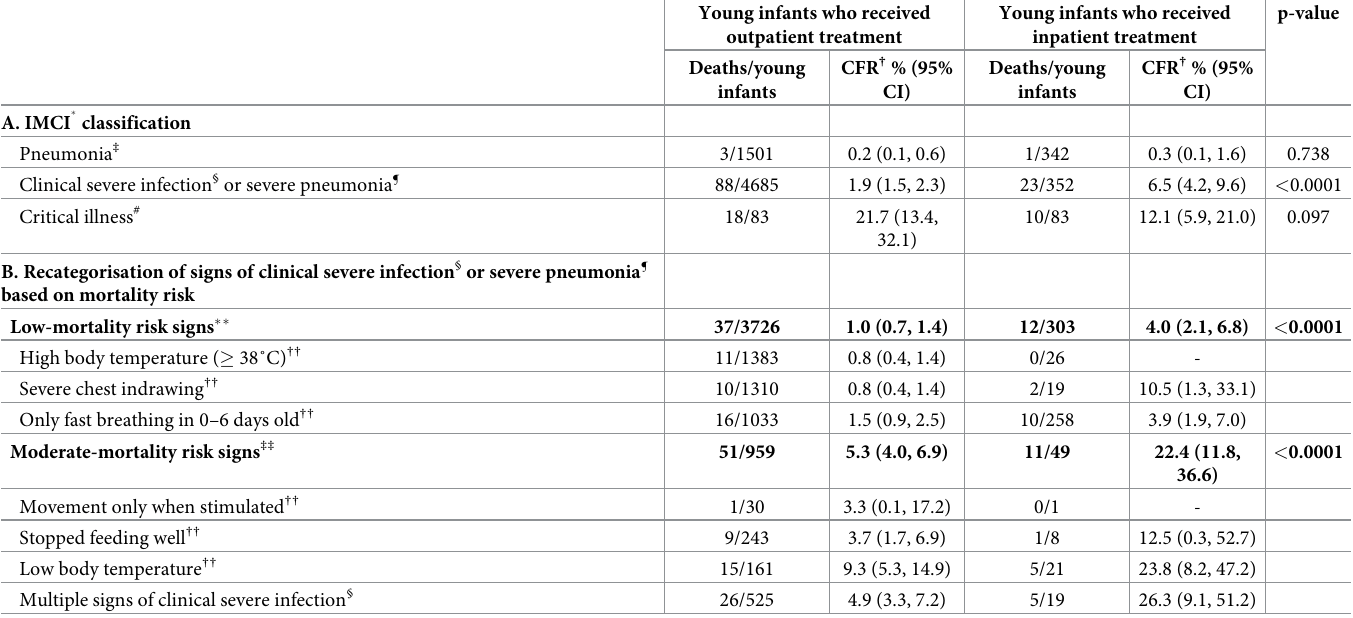
Table 3. Case fatality ratio (CFR) comparison by the place of treatment and by IMCI � classification [23] and recategorisation of signs of clinical severe infection or severe pneumonia on mortality risk (n =